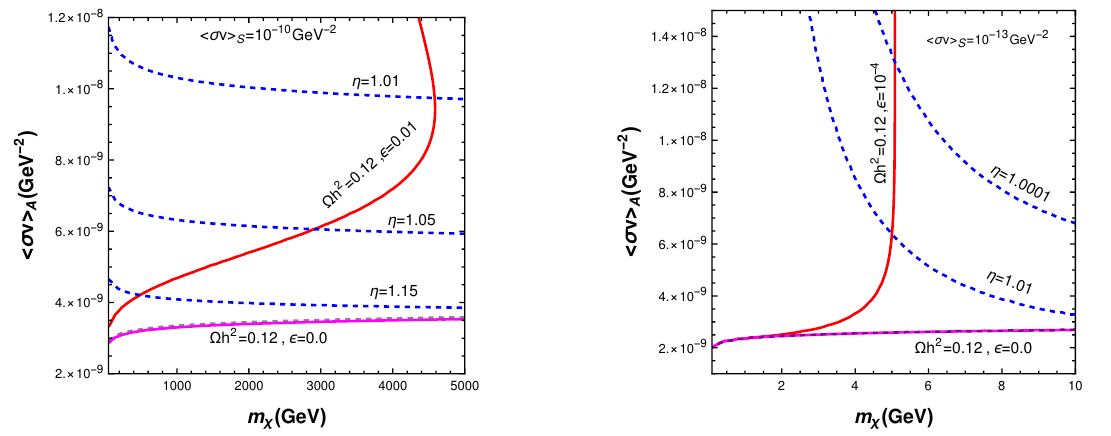
Figure 7 . Required values of the pair-annihilation cross-section mass m (cid:31) that can reproduce the observed DM relic abundance (red solid line). The results are shown for di(cid:11)erent values of the CP-violation parameter (cid:15) and the semi-annihilation rate (left and right plots). Corresponding results for the symmetric case ( (cid:15) = 0) are also shown for comparison, with semi-annihilation (black dashed line) and without it (pink solid line), the latter case being the pure WIMP scenario. Also shown are the contours for the present DM relative abundance parameter (cid:17) . See text for